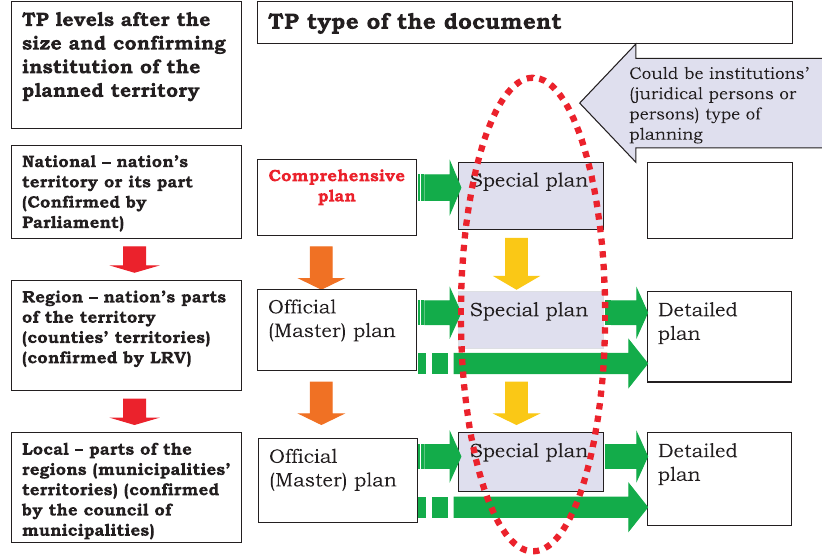
Fig. 3. The existing and the suggested simpler system of ranking of territory